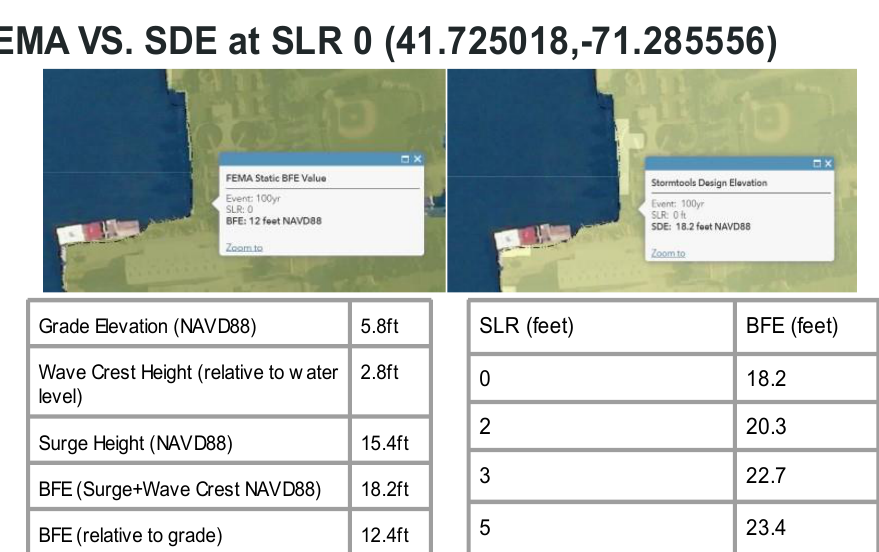
Figure 4. Grade elevation, 100 yr surge height, wave crest height, BFE relative to NAVD88 and grade (lower-level left panel) and impact of SLR on BFE from SDE maps with sea level rise (lower, right panel) for 100 yr flooding. The upper-level left panel shows FEMA BFE, relative to NAVD88, and upper right panel shows BFE, relative to NAVD88, based on SDE maps for the facility for no SLR. The FEMA HAZUS WWTF damage curves are shown in Figure 5 [6,7]. Values are provided for average, more than average, and less than average vs. inundation levels. The reference levels for inundation are not specified, but it is assumed that this represents elevation relative to when the facility becomes inundated. Only one curve is provided for the entire facility, so it assumed that the curve represents the average for all components of the facility. With this assumption the present analysis determined the critical flood el- evation (CFE) for each component of the facility and then estimated the level of inunda- tion for each component above the CFE. The CFE represents the elevation above which flood waters cause damage to the facility. Figure 6 shows an example of the CFE for the primary clarifier and emergency generators for the Warren WWTF.